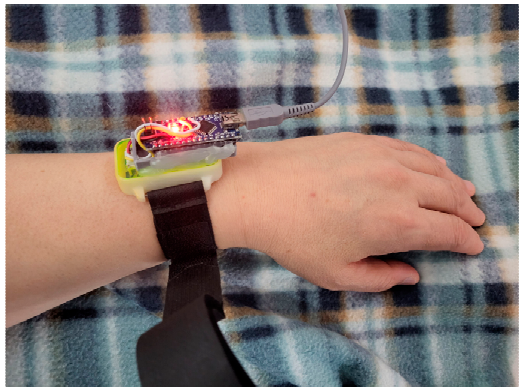
Figure 9. Band-type heart rate-measuring device.